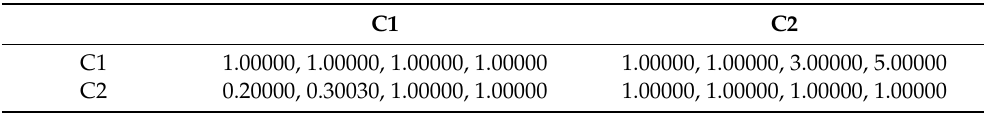
Table 4. HF Pairwise Comparison Matrix at level 1.